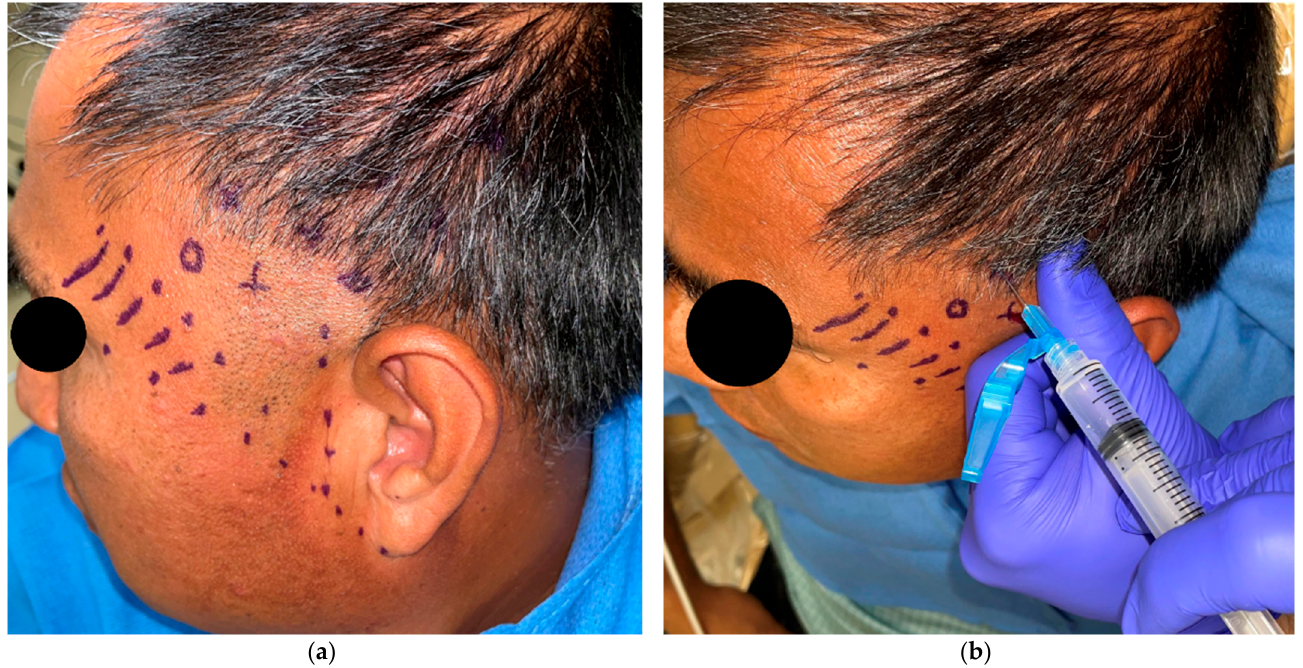
Figure 2. ( a ): Trigger points (X), Taut bands without referral (O), dashed lines = predicted path of facial nerve. ( b ): Injection of local anesthetic into each trigger point. facial nerve. ( b ): Injection of local anesthetic into each trigger